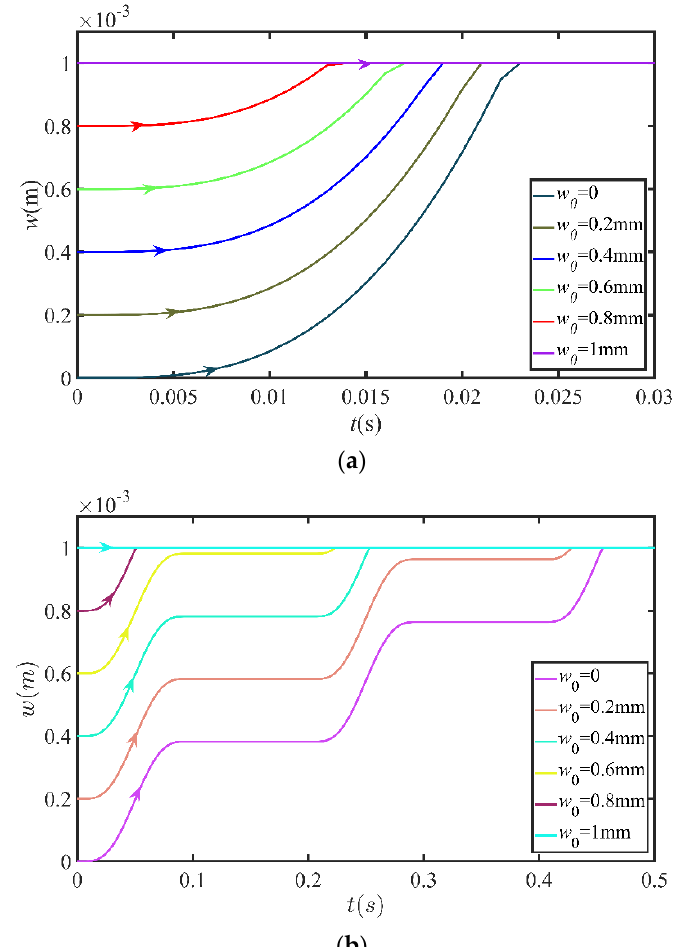
Figure 11. AC response with parasitic capacitance taken into account. Using sinusoidal signal v m ( t ) = V 0 sin ( 2 π ft ) , with f = 5 Hz and V 0 = 0.5 V as the AC excitation, ( a ) is obtained. ( b ) corre- sponds to V 0 = 0.1